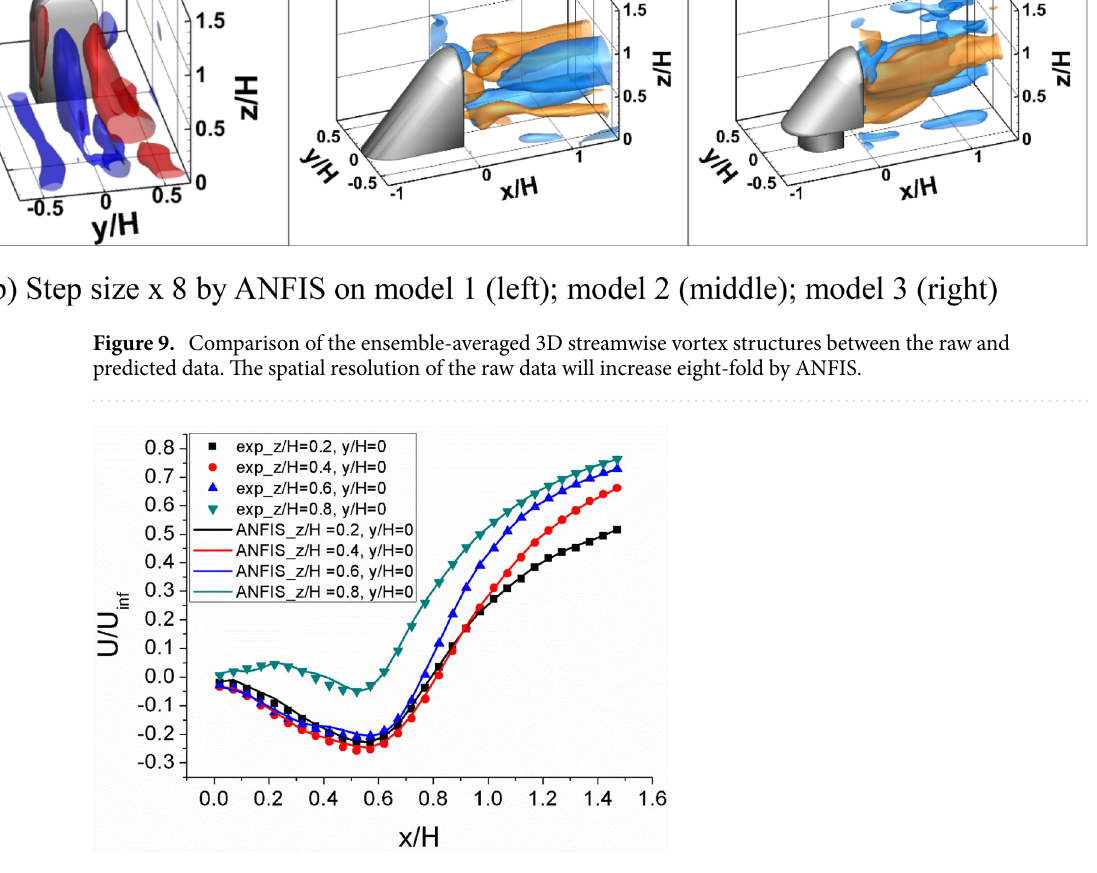
Figure 10. A comparison of normalized average streamwise velocity for experimental result and ANFIS data prediction of model 1 along the x/H at z/H = 0.2 ~ 0.8, y/H =